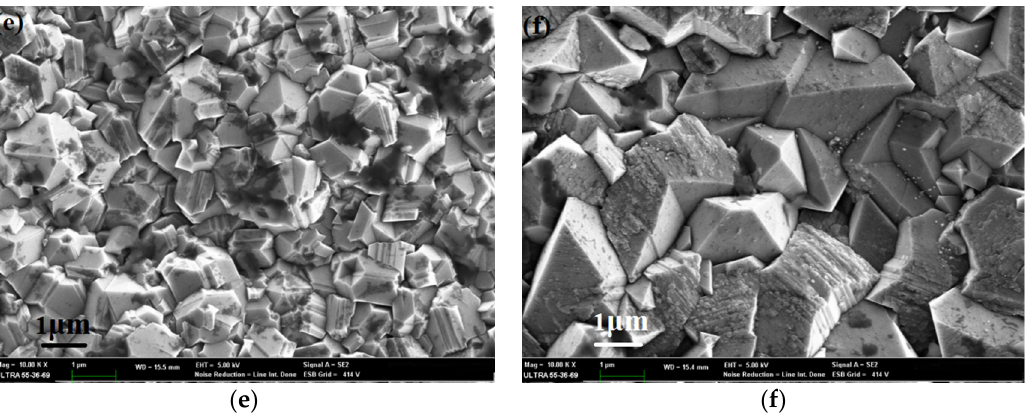
Figure 1. SEM surface morphology of Si ‐ doped diamond film with various silicon concentrations: ( a ) 0 atom %; ( b ) 0.11 atom %; ( c ) 0.52 atom %; ( d ) 0.98 atom %; ( e ) 1.41 atom %; ( f ) 1.81 atom %. In order to check the five major diffraction peaks of diamonds {111}, {220}, {311}, {400}, and {331}, correspondingly at 43.8°, 75.3°, 91.4°, 119.5°, and 140.5°, all samples were examined with a scanning angle from 20° to 145°. The XRD patterns for the diamond films fabricated at various silicon concentrations are shown in Figure 2. The diffraction peaks of diamonds {111} and {220} with different intensities were observed, which, with further evidence, confirmed the diamond nature of these films. Shifts of these peaks to a higher angular position indicated the presence of compress stress, caused by the mismatch of the thermal coefficients of film and substrate material. The ratio of the diamond peak {220}/{111} for different silicon concentrations were 0.5, 1.83, 2.26, 2.92, 1.86, and 0.59 respectively. It suggested that the peak {111} become weaker with silicon dopant, as compared with the conventional diamond films.